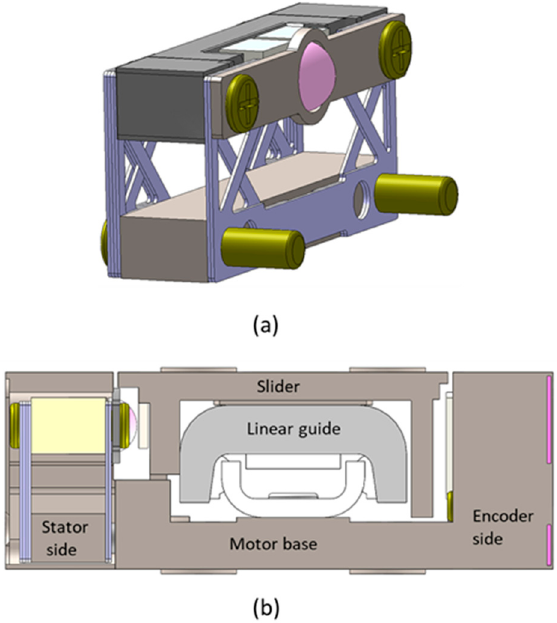
Figure 20. Perspective view of the stator ( a ) and end view of the inertia-drive-type motor ( b ). The stator has six spring layers, two at the front and four at the back (2 + 4). The pressing force springs on the front side were always constrained to two, and the number of spring layers at the back could be decreased or increased to change the pressing force, thus holding force of the slider.